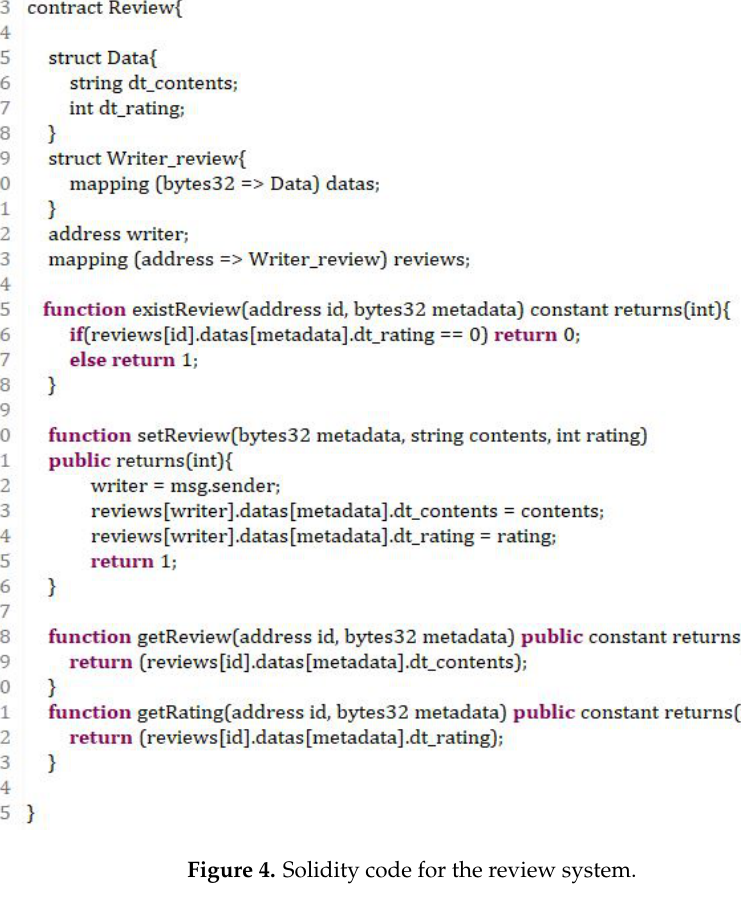
Figure 4. Solidity code for the review